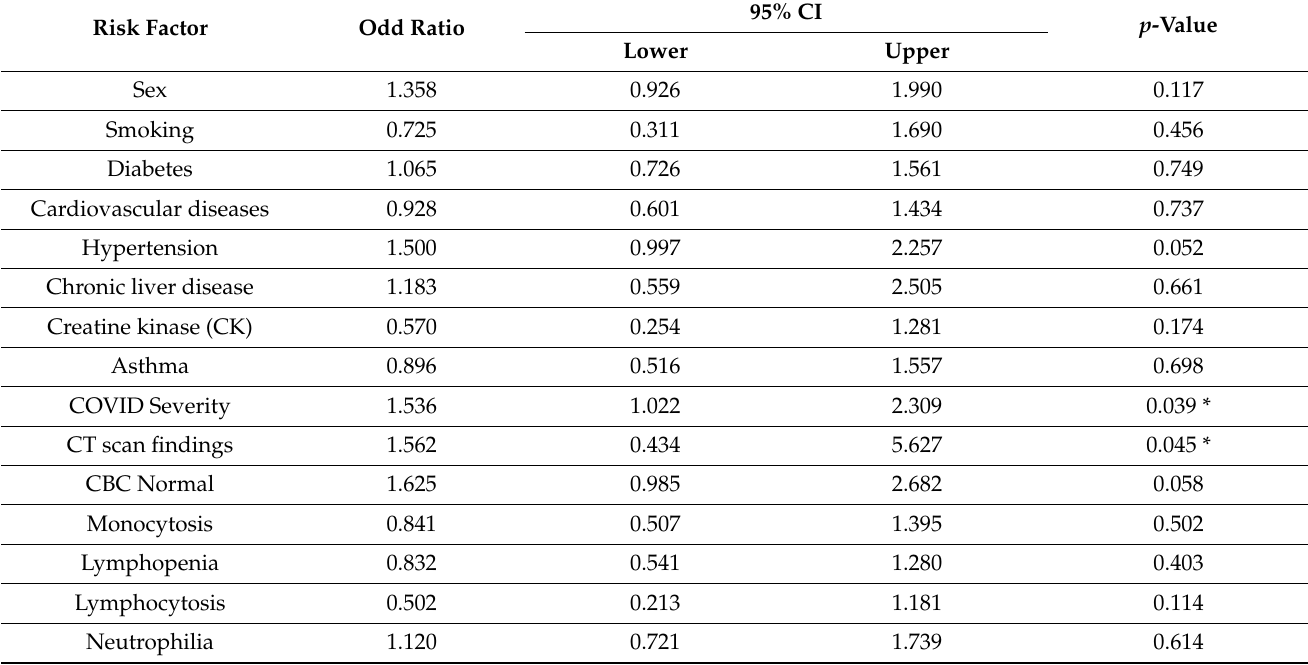
Table 7. Multivariant logistic regression analysis for factors affecting